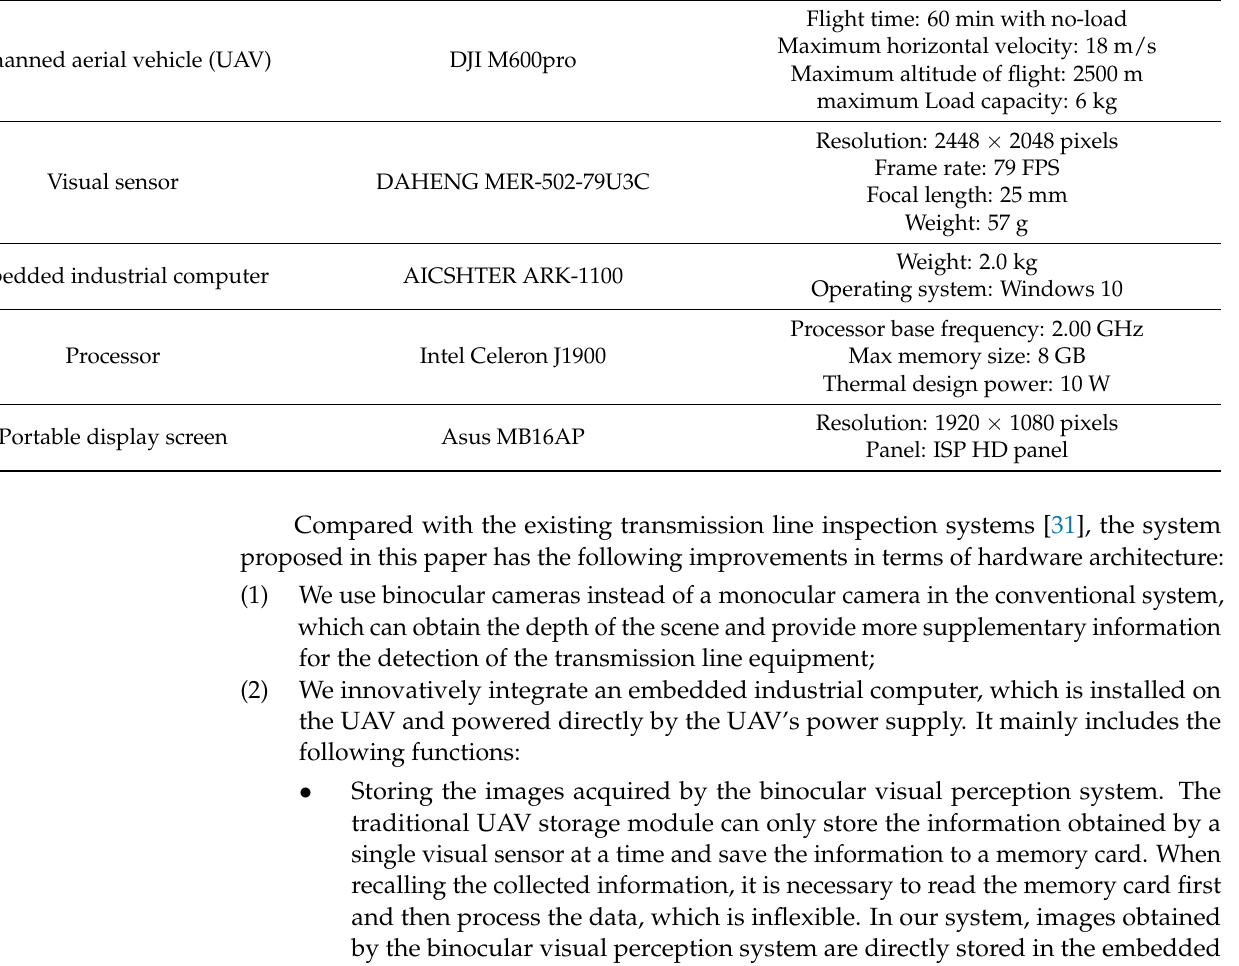
Table 2. Hardware devices used in this study for inspection of transmission lines.